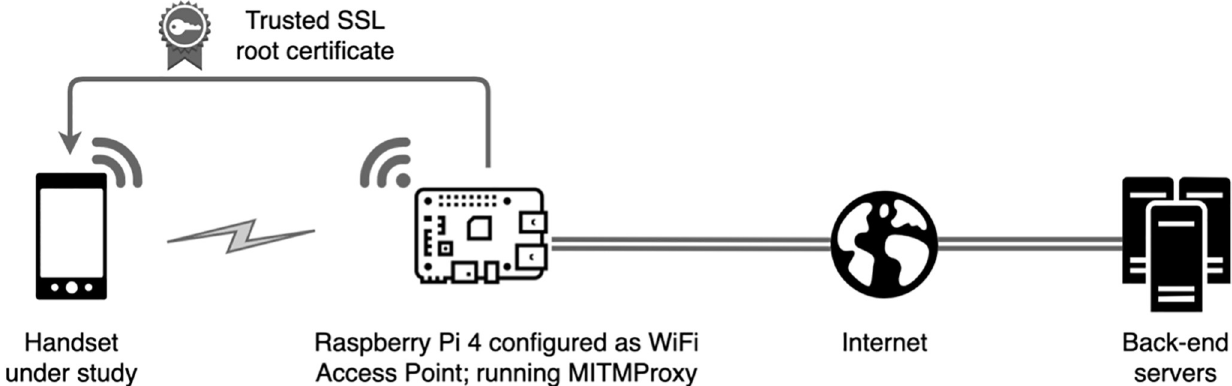
Fig 1. Measurement setup. Mobile handset configured to access the Internet using a WiFi access point hosted on a Raspberry Pi. A system certificate is installed on the phone to be able to decrypt outgoing traffic. The laptop pretends to any process running on the handset to be the destination server, creates a connection to the actual target, and relays requests and their replies between handset and server while logging the traffic.